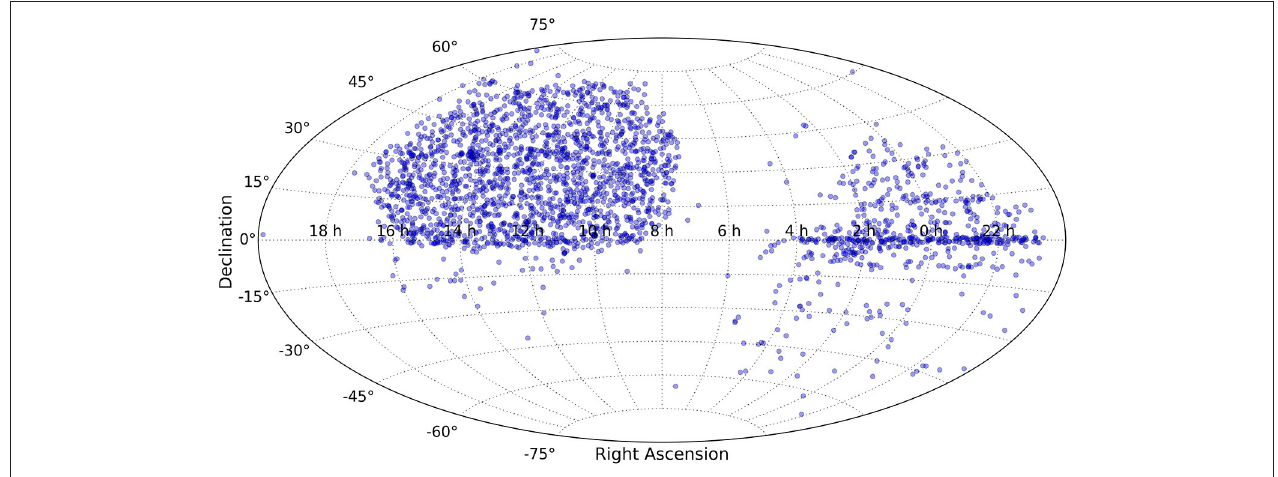
FIGURE 1 | Sky coverage of the sources at the current state of the